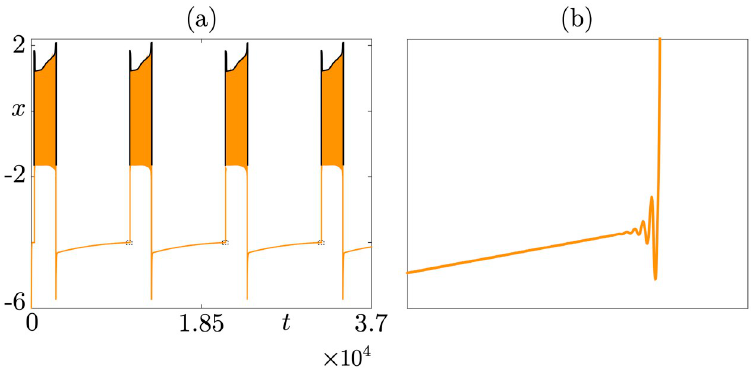
Fig 12. A folded-node/cyclic folded-node bursting example. The x -times series of the folded-node/cyclic folded- node bursting solution is shown in panel (a), where the upper envelope of the burst phase has been traced in black in order to better show the small-amplitude oscillations of this envelope due to the presence of a cyclic folded node; panel (b) is a zoom of panel (a) near the classical folded node highlighting small-amplitude oscillations throughout the silent phase. Equations and parameter values are given in S1